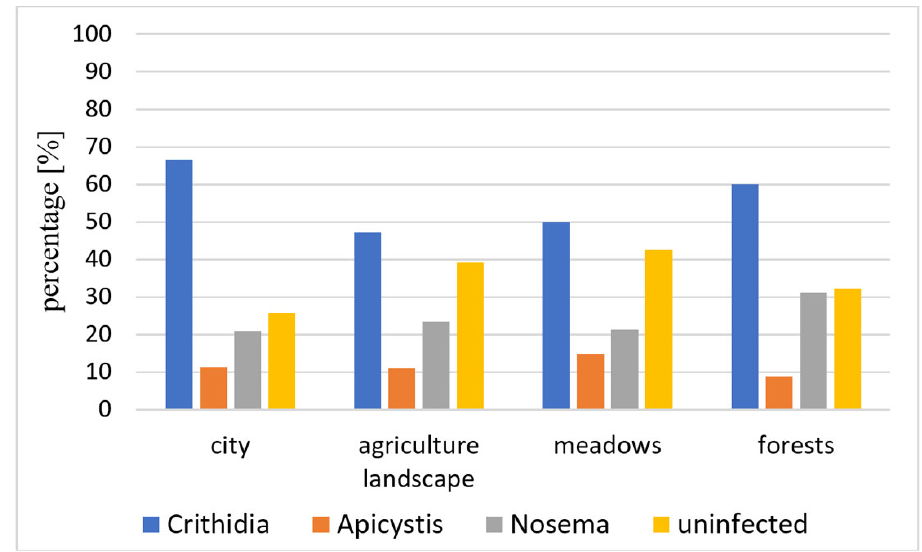
Figure 5. Presence of pathogens in B. terrestris/lucorum in various categories of landscape type independent of caste.